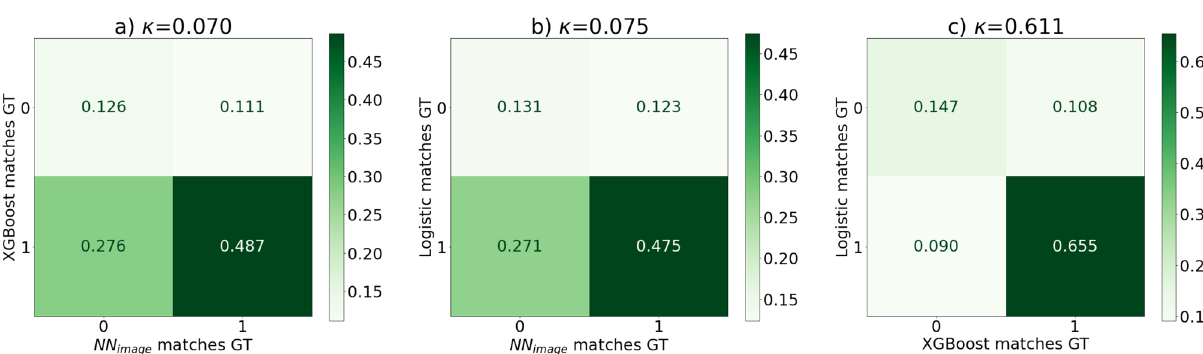
Figure 3. The explainable model generates explanations for its predictions via the output attention map created for each input image based on the metadata columns. Outputs are highlighted with red (prognosis and the attention maps over the input meta columns).